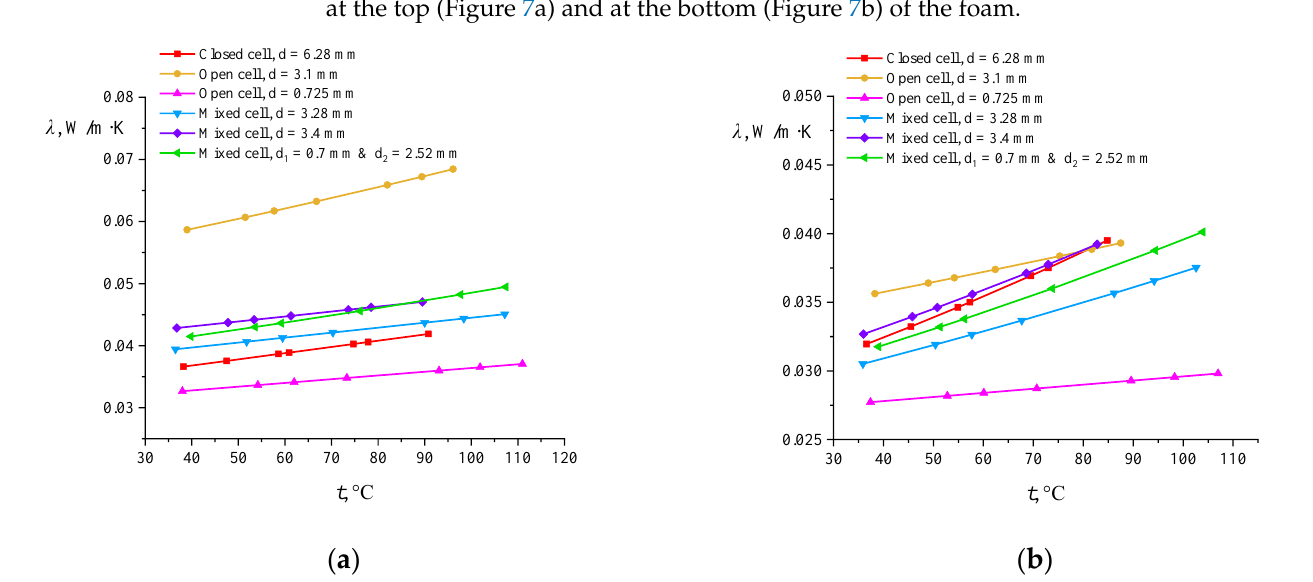
Figure 7. Thermal conductivity of polyurethane foam samples as a function of temperature in the case of heating from the side: ( a ) measurement results at the top of the sample; ( b ) measurement results at the bottom of the sample.